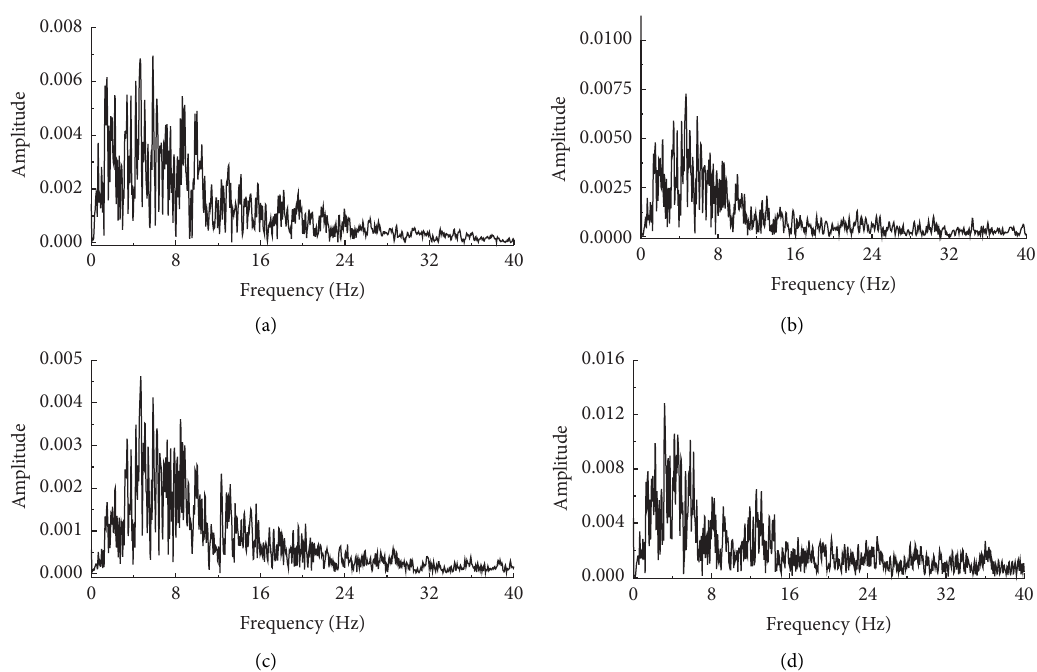
Figure 14: Acceleration Fourier spectrum of test 4 soil layer under EL-3 ground motion input. (a) A1. (b) A3. (c) A4. (d)